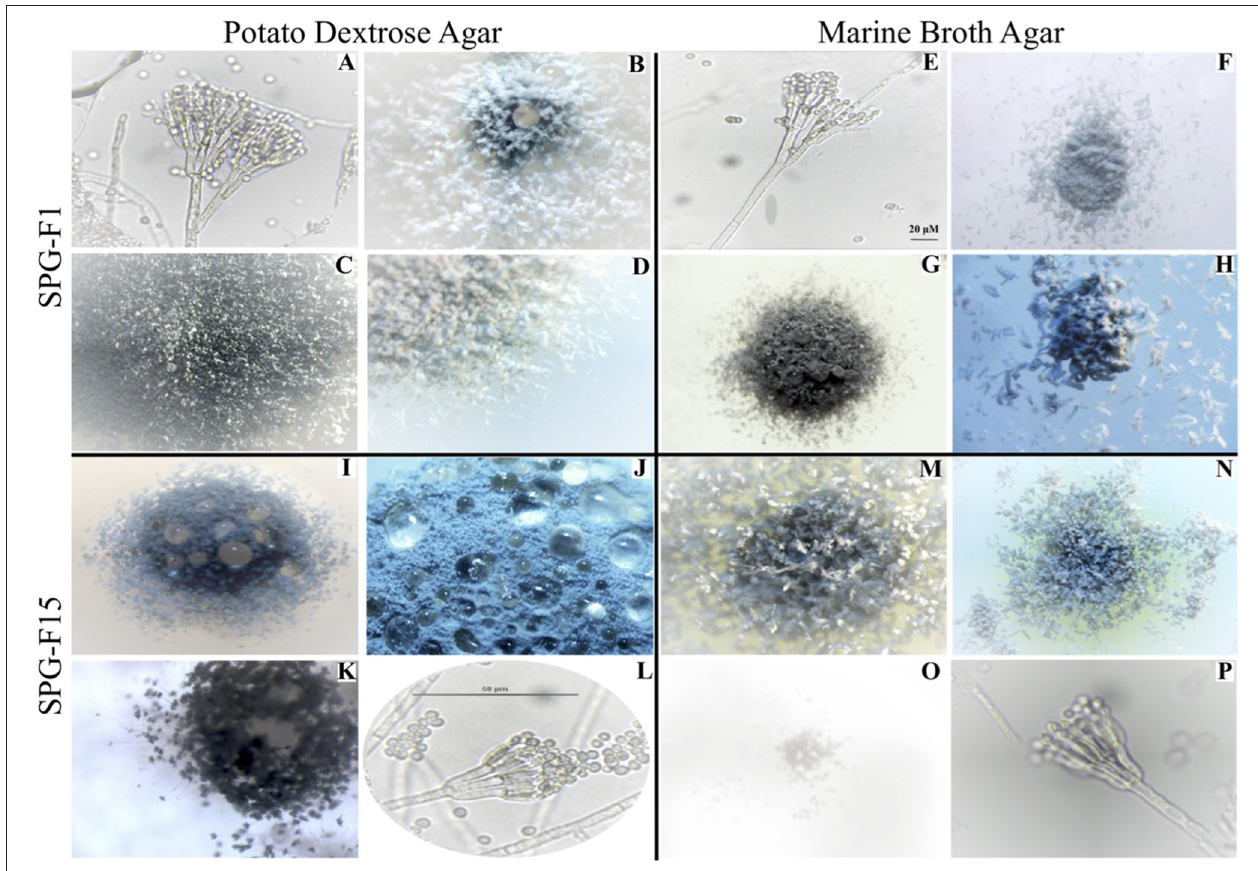
FIGURE 2 | Microscopic images showing morphological characteristics of isolate SPG-F1 from U1371E-14H2 (A–H) and isolate SPG-F15 from U1368D-2H1 (I–P) grown on either potato dextrose agar (A–D,I–L) or marine broth agar (E–H,M–P) .